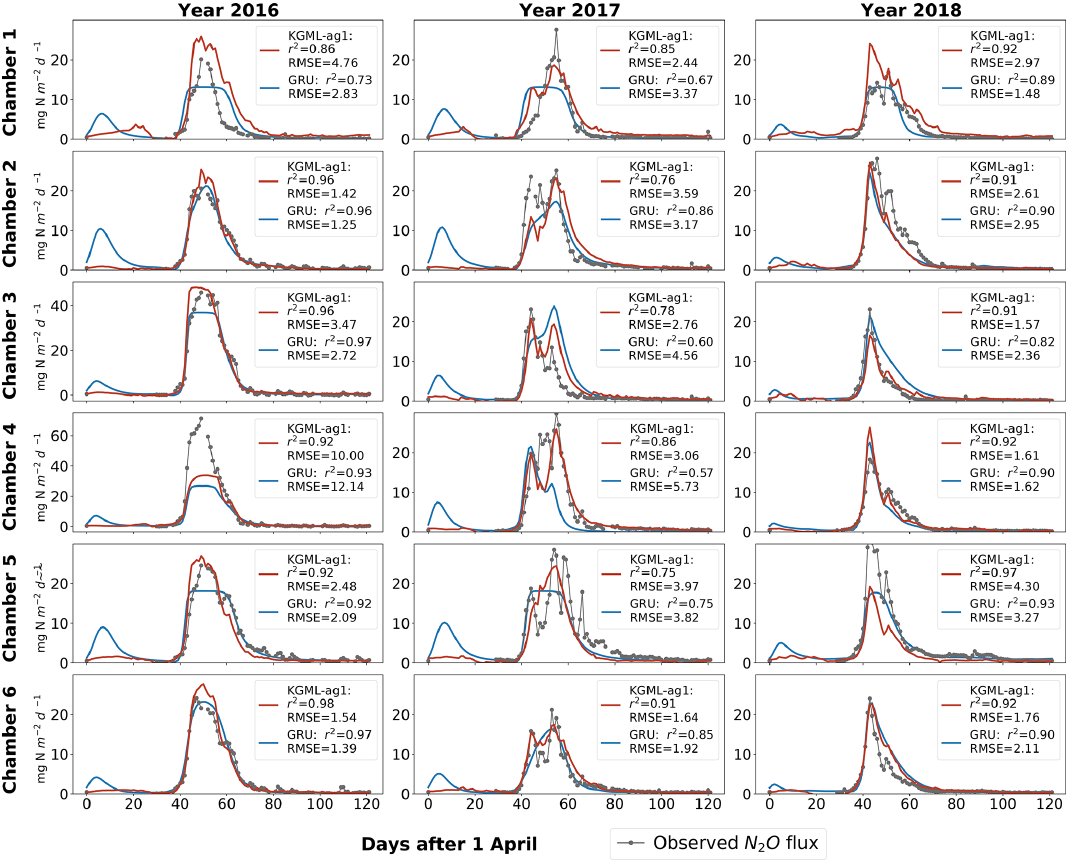
Figure 2. Leave-one-out cross validation of time series of N 2 O flux (mgNm − 2 d − 1 ) predicted by the pure non-pre-trained GRU model (blue line) and KGML-ag1 model (red line). Observations are shown as black line dots. Validation results for each chamber were based on out-of-sample predictions by models trained by the other five